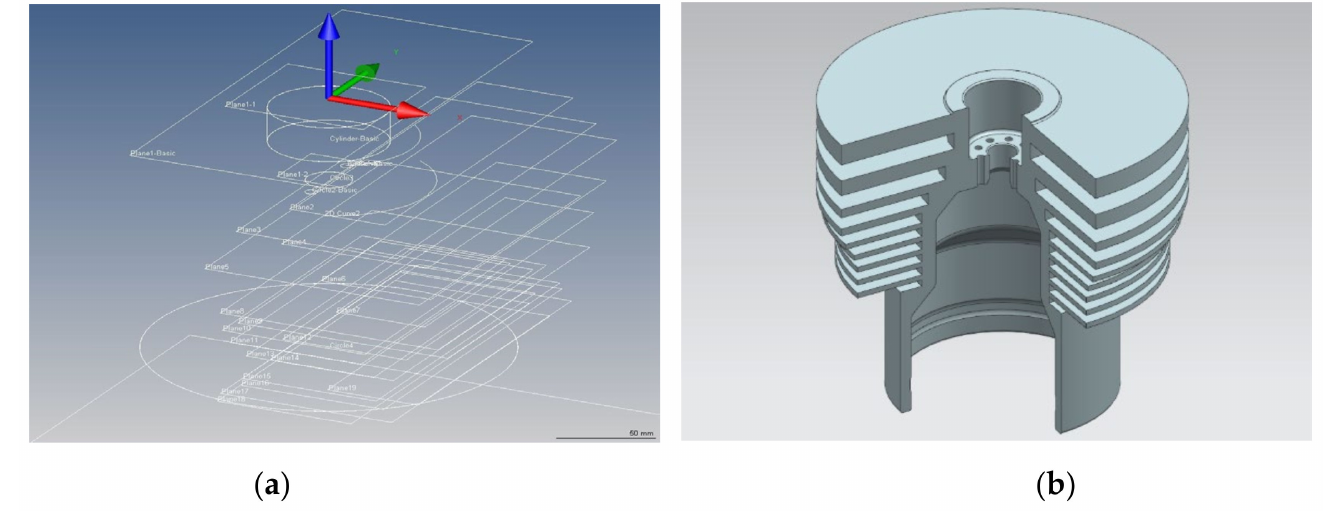
Figure 2. Coordinate measuring machine used for measuring the surface profile and reconstruction of the solid model. ( a ) Blade thickness and stage-interval measurements; ( b ) reconstruction of the 3D solid model obtained using CAD